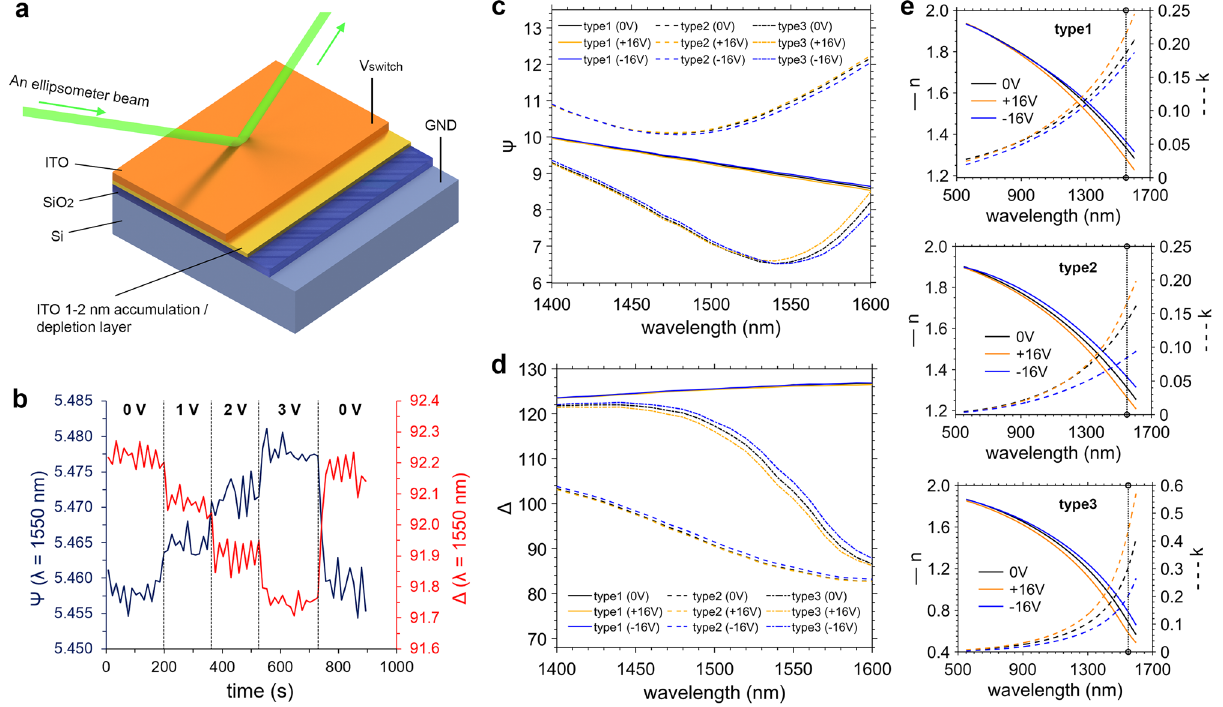
Figure 5. ( a ) Ellipsometry model measurement scheme; ( b ) ITO (type3) ψ and Δ at wavelength of 1550 nm; ( c ) ψ; ( d ) Δ of the multilayer stack in the wavelength range from 1400 to 1600 nm at voltages of − 16 V and + 16 V; ( e ) film types 1–3 accumulation layer n and k in the wavelength range from 550 to 1600 nm at voltages of 0, + 16 and − 16